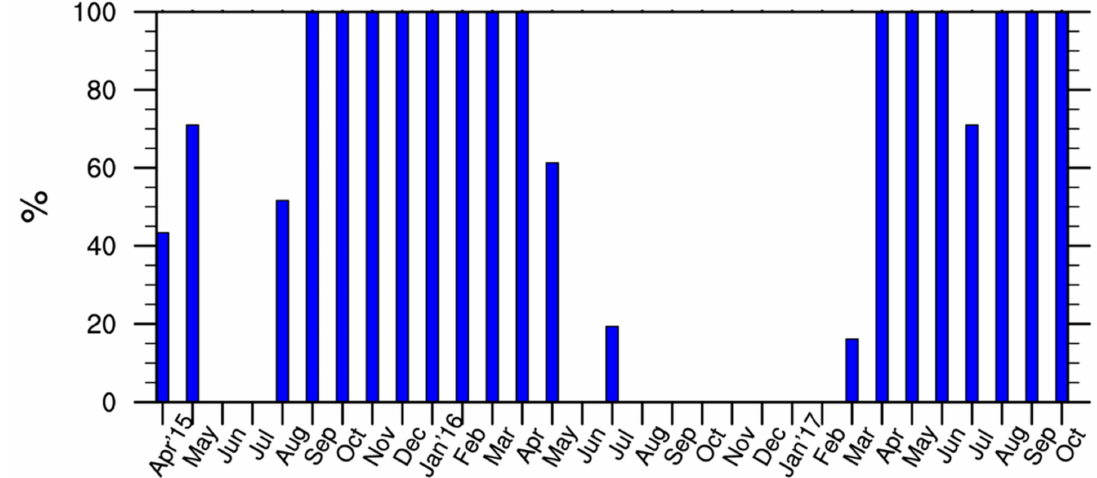
Figure 2. Percentage of days in the corresponding month for which ceilometer data are available. Note that months with more than 70% days of data are used for the